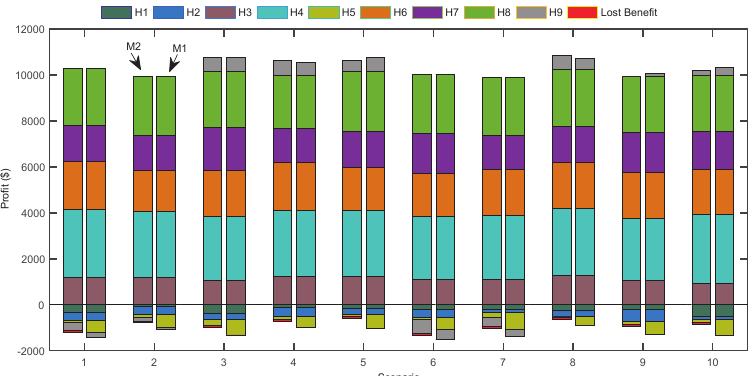
Figure 9. Total profits of PEV owners under M1 and M2 in the DA market in ten